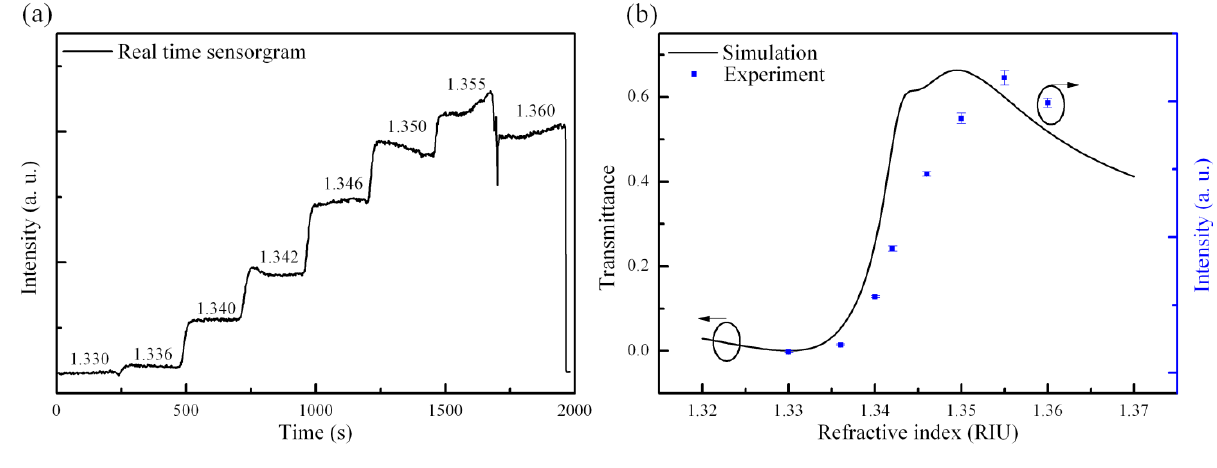
Figure 4. ( a ) Real-time response for 8 different refractive index solutions; ( b ) simulated and experimental intensity response; the error bar (one σ is depicted) stands for the noise level calculated from real-time